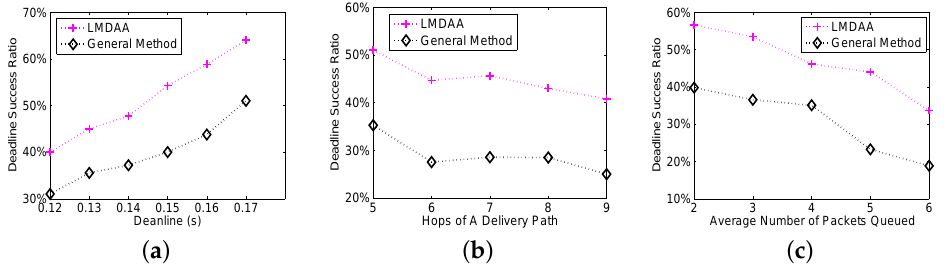
Figure 5. Deadline success ratio by NS2 simulation. ( a ) DSR vs. deadlines; ( b ) DSR vs. the number of hops; ( c ) DSR vs. the average number of packets queued.